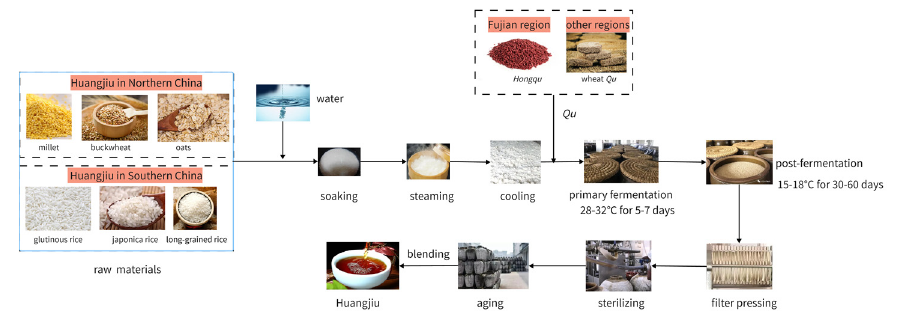
Figure 1. The traditional production process of Huangjiu.